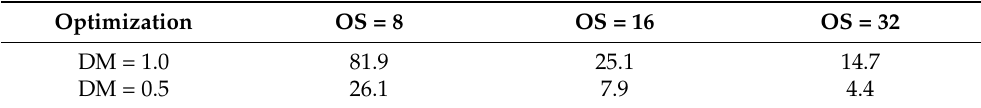
Table 7. Temporal computational cost (in GFLOPs) with different parameterisations.